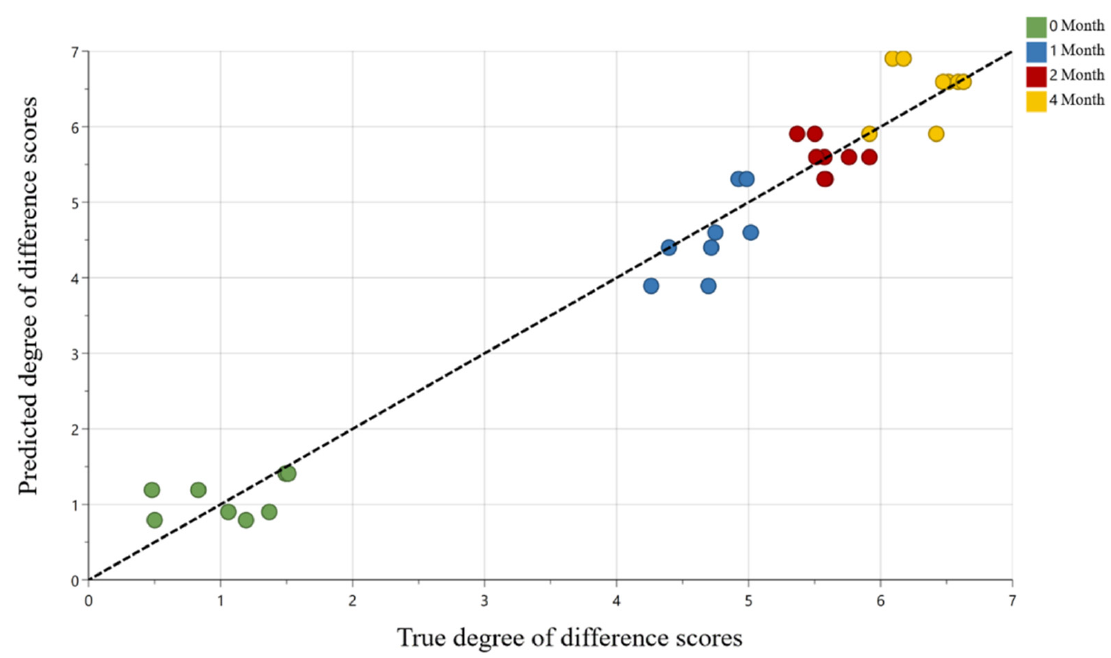
Figure 1. Regression plot of the predicted versus true degree of difference (DOD) scores from the OPLS model (Pareto scaling) correlating LC/MS chemical profiling from 16 RTD coffee samples in biological replicate. OPLS model quality values were R 2 Y = 0.966 and Q 2 = 0.960 with a root mean squared error of prediction of 0.4 out of a total of 10 points. Coffee samples color-coded by storage time.